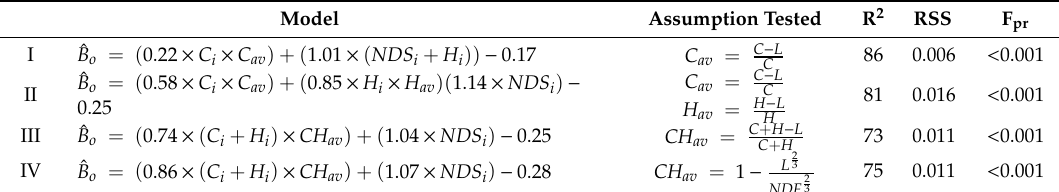
Table 4. Equations, number of parameters (p), coe ffi cient of determination (R 2 ), and significance ( RSS) for the estimation of anaerobic biodegradability based on a deterministic approach.